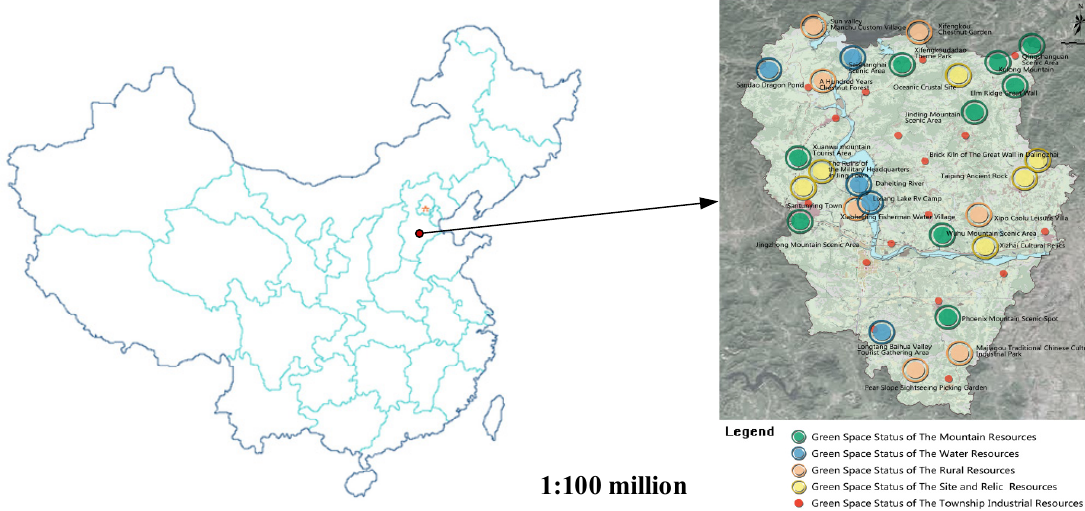
Figure 1. Green Land Condition in the County.